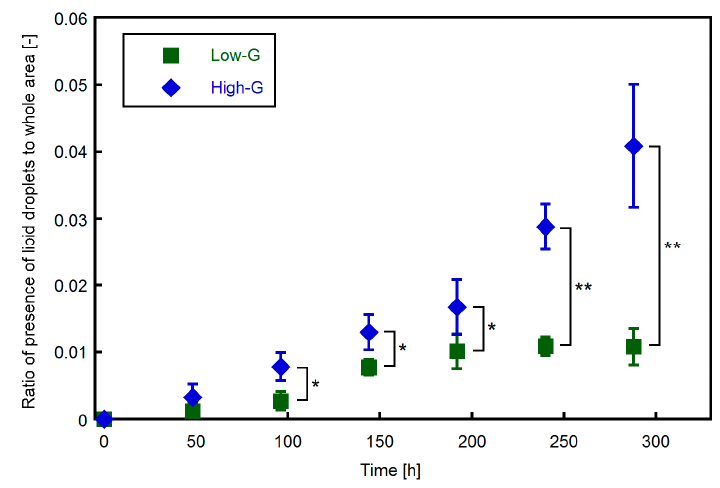
Figure 6. Area proportion of lipid droplets in phase-contrast microscopic images. The amount of lipid droplets in the high-G group was significantly larger than that in the low-G group after t = 96 h. Data are presented as mean ± S.D., n = 4. * and ** indicate significant differences between low-G and high-G groups (*: p < 0.05, **: p < 0.01).